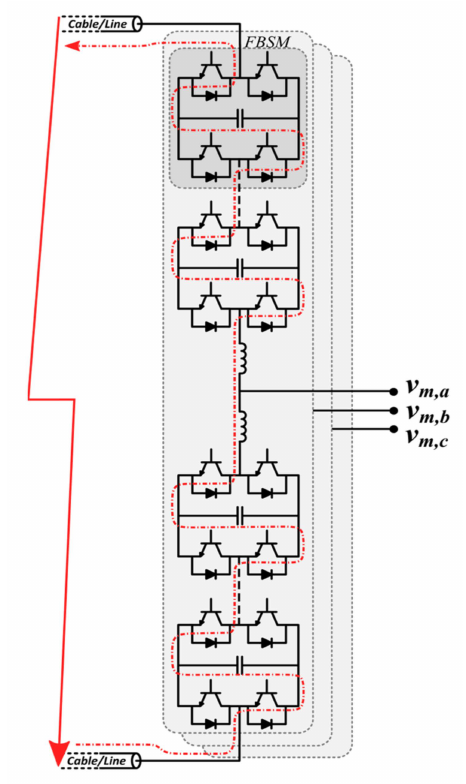
Figure 7. DC fault current flow in MMC-based FBSM